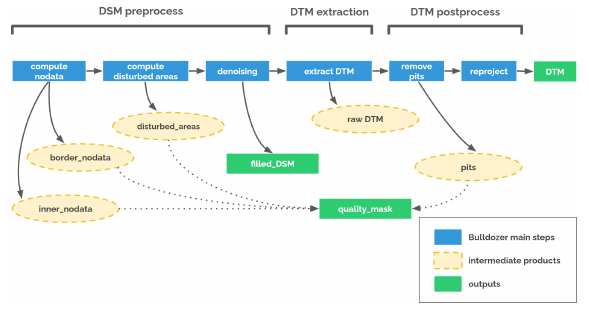
Figure 4. Bulldozer simplified pipeline.